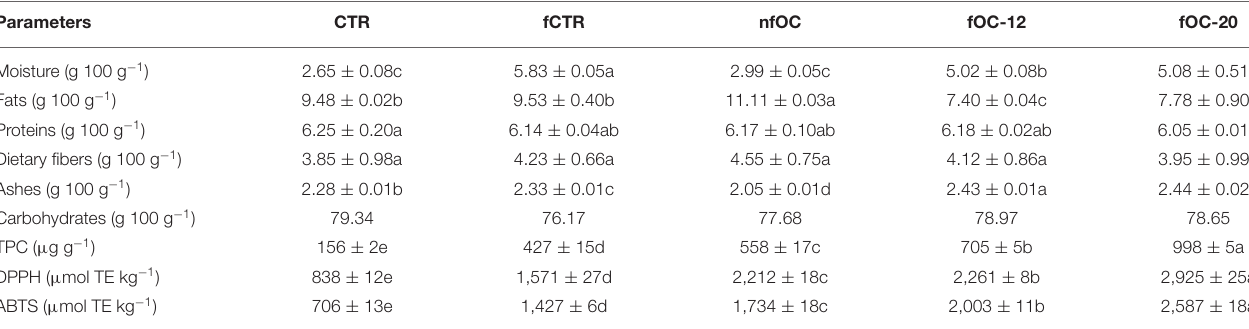
TABLE 3 | Proximate composition and antioxidant activity of breadsticks. Parameters